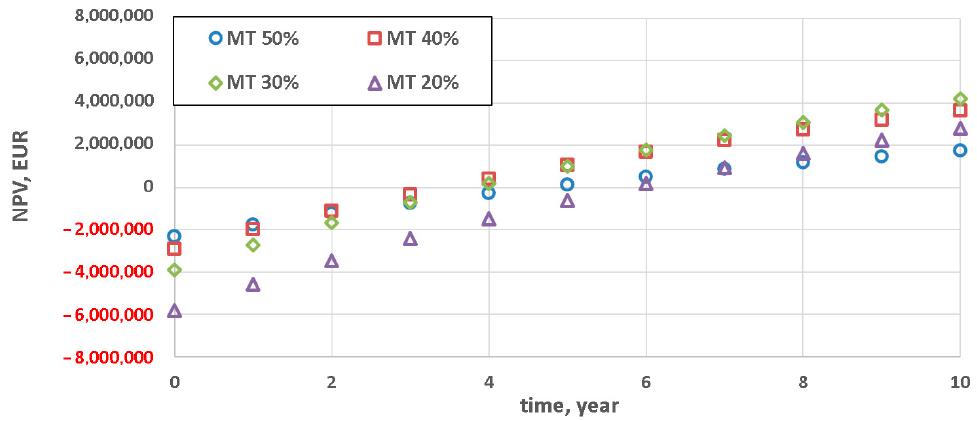
Figure 4. Results of NPV analysis for different variants of achievable power unit technical minimum (MT) at coefficient Y = 0.5 (identical power of plasma torches assumed for all technical minimum levels).